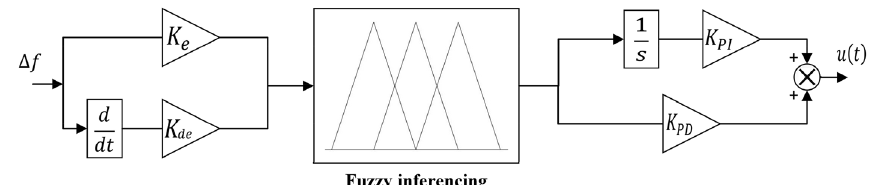
Fig. 11 Schematic of the fuzzy controller